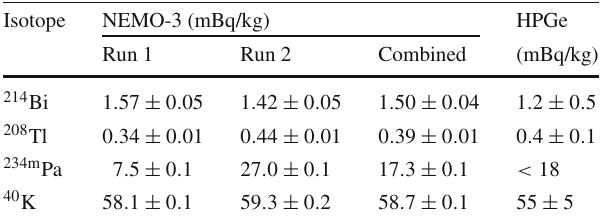
Table 1 Measurements of the specific activity of 82 Se source foils for different isotopes, made with the NEMO-3 detector and independently with an HPGe detector. Equal numbers of 82 Se foils from enrichment runs 1 and 2 were measured together in the HPGe detector, so the NEMO-3 combined values are the mean values of the specific activities fromeachenrichmentrun.Allerrorbarsarestatisticalonlyandareatthe 1 σ level. The limit shown is at the 2 σ level. The HPGe measurements are taken from